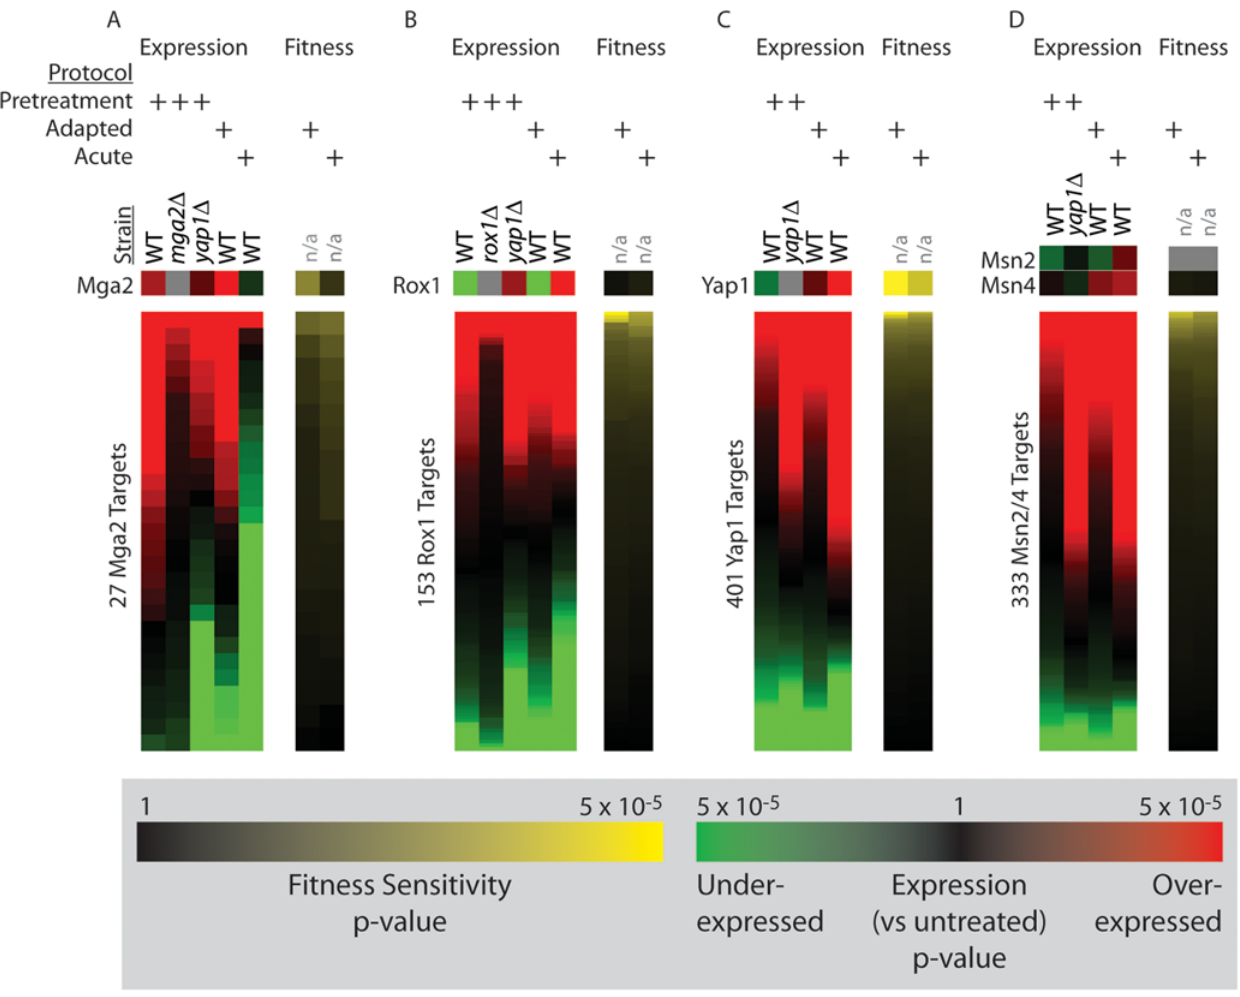
Figure 5. Expression analysis of deletion mutants validates the activation of key transcription factors in response to H 2 O 2 pretreatment. Panels A–D detail the behavior of the transcription factors Mga2, Rox1, Yap1, and Msn2/4 and their target sets, respectively. Each column represents the expression or fitness values in sorted order for a specific set of genes.